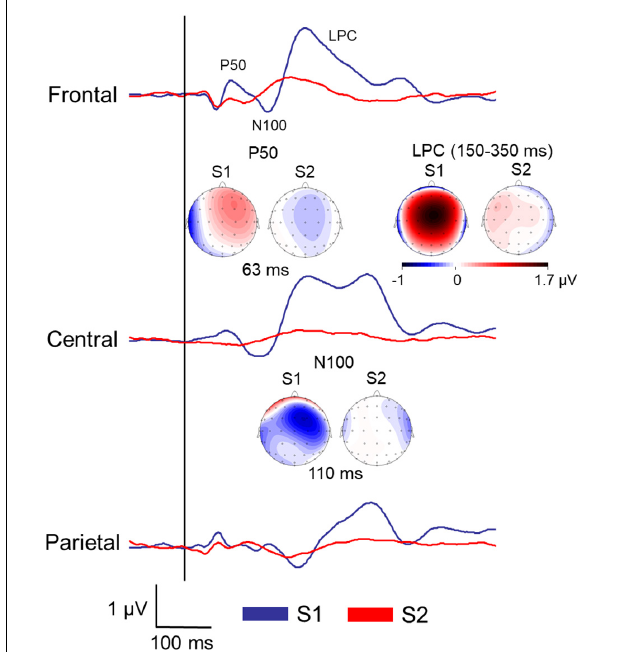
FIGURE 2 | Grand averages of the somatosensory ERPs elicited by the first (S1) and the second stimuli (S2) of all the participants before the brain stimulation (pre) at the three regions of interest (ROI). Topographical maps of the P50 and N100 amplitudes at specific latencies, and late positive complex (LPC) mean amplitude were also